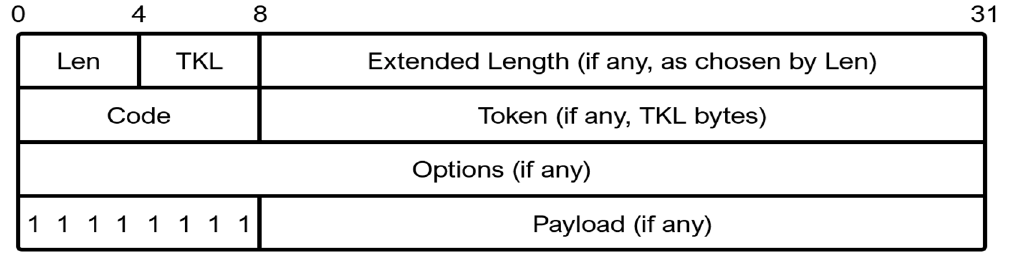
Figure 5. CoAP over TCP header format.